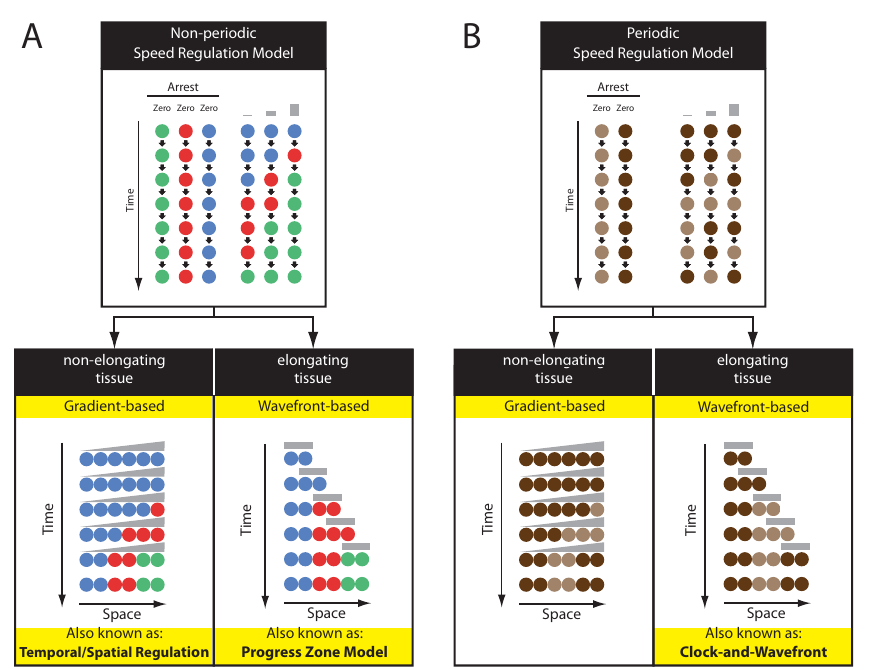
Fig 6. The SR model (see also Box 3). (A) Top panel: In nonperiodic SR model, a speed regulator (shown in gray) modulates the speed of cellular state transitions (each cellular state is shown in a different color) in a dose-dependent fashion (top panel, right). At a very low or zero concentration of the speed regulator, cellular state transitions are arrested (top panel, left). (A) Bottom panel: The SR model can operate in a gradient-based mode to pattern nonelongating tissues (left) or in a wavefront-based mode to pattern elongating tissues (right). (B) If the processes driving cellular state transitions is periodic (i.e., driven by a clock, which expression is shown in brown; top panel), the SR model can generate periodic patterns in both elongating and nonelongating tissues (via a wavefront-based and gradient-based modes of the model, respectively). SR, speed